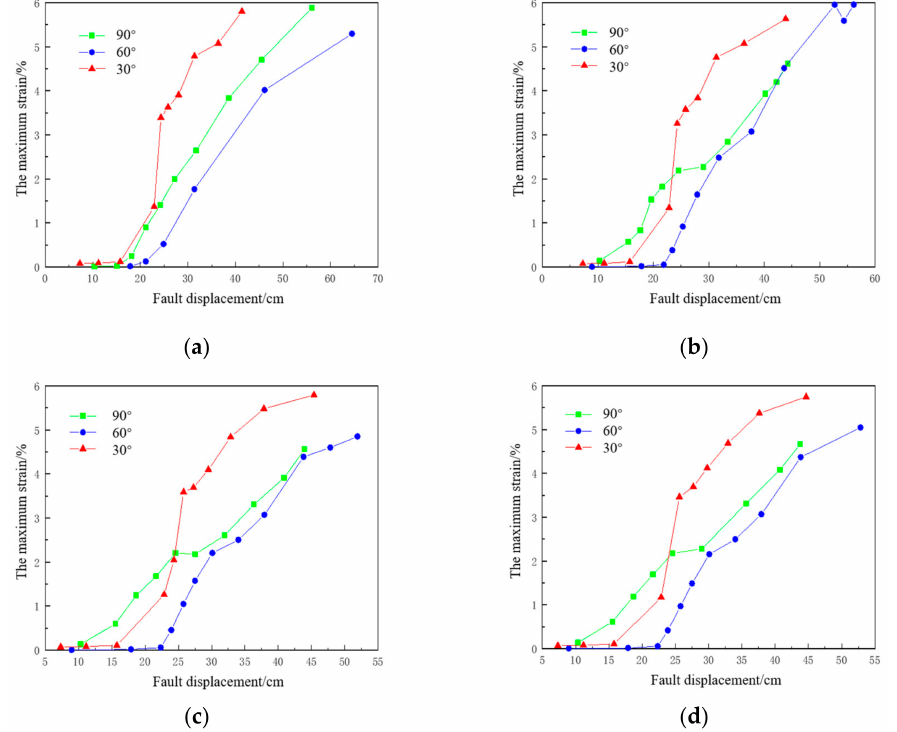
Figure 14. The maximum strain change law of pipeline under different included angles: ( a ) 168.3 × 4.5; ( b ) 168.3 × 5.0; ( c ) 168.3 × 5.5; ( d ) 168.3 ×